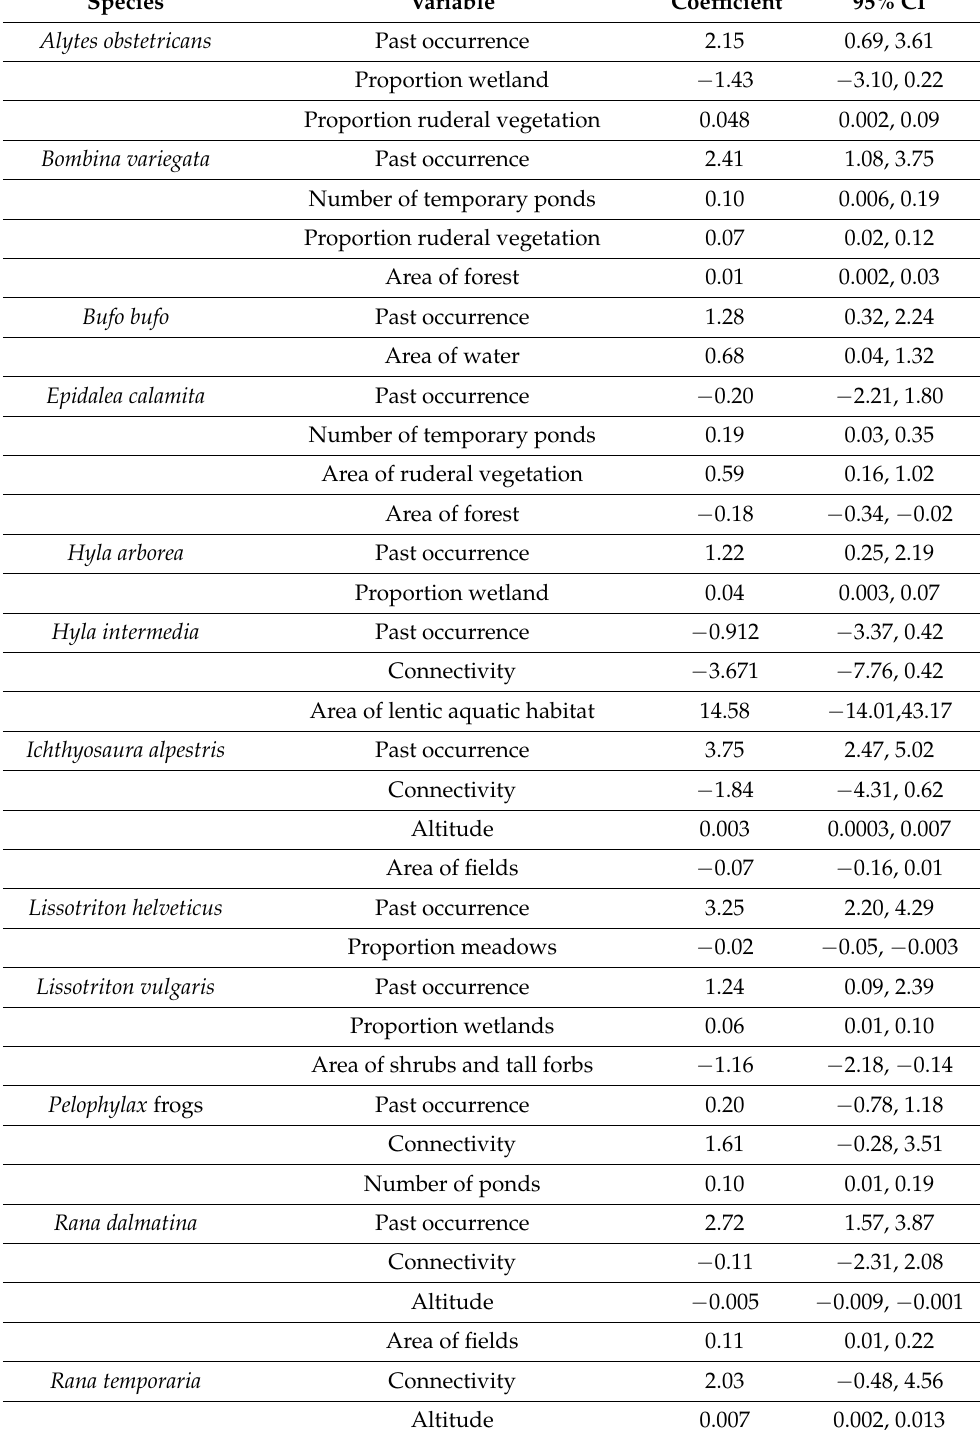
Table 2. Parameter estimates of the final models. The coefficients are the logit-scale estimates for the relationship between occupancy and the explanatory variable. See text for additional explanation and Table 1 for explanation of explanatory variables. CI: confidence